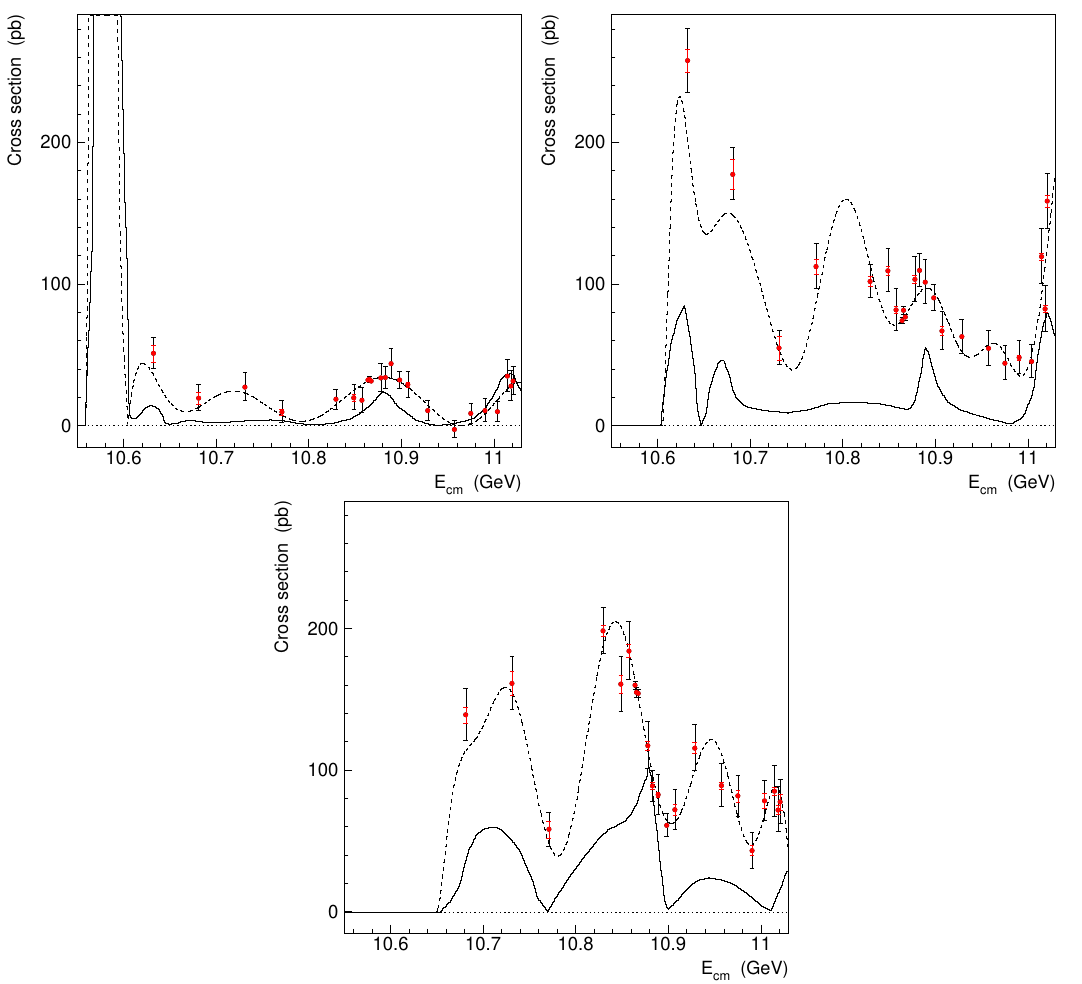
Figure 12 . Measured dressed cross sections at various energies for e + e − → B ¯ B (left), e + e − → B ¯ B ∗ (right), and e + e − → B ∗ ¯ B ∗ (bottom). Points and dashed curves are the same as in figure 8. Solid curve shows the predictions of the Unitarized Quark Model